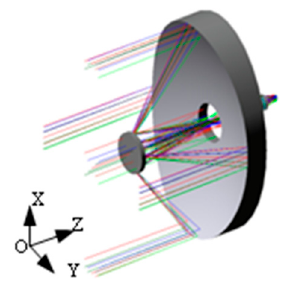
Figure 1. Optical system.